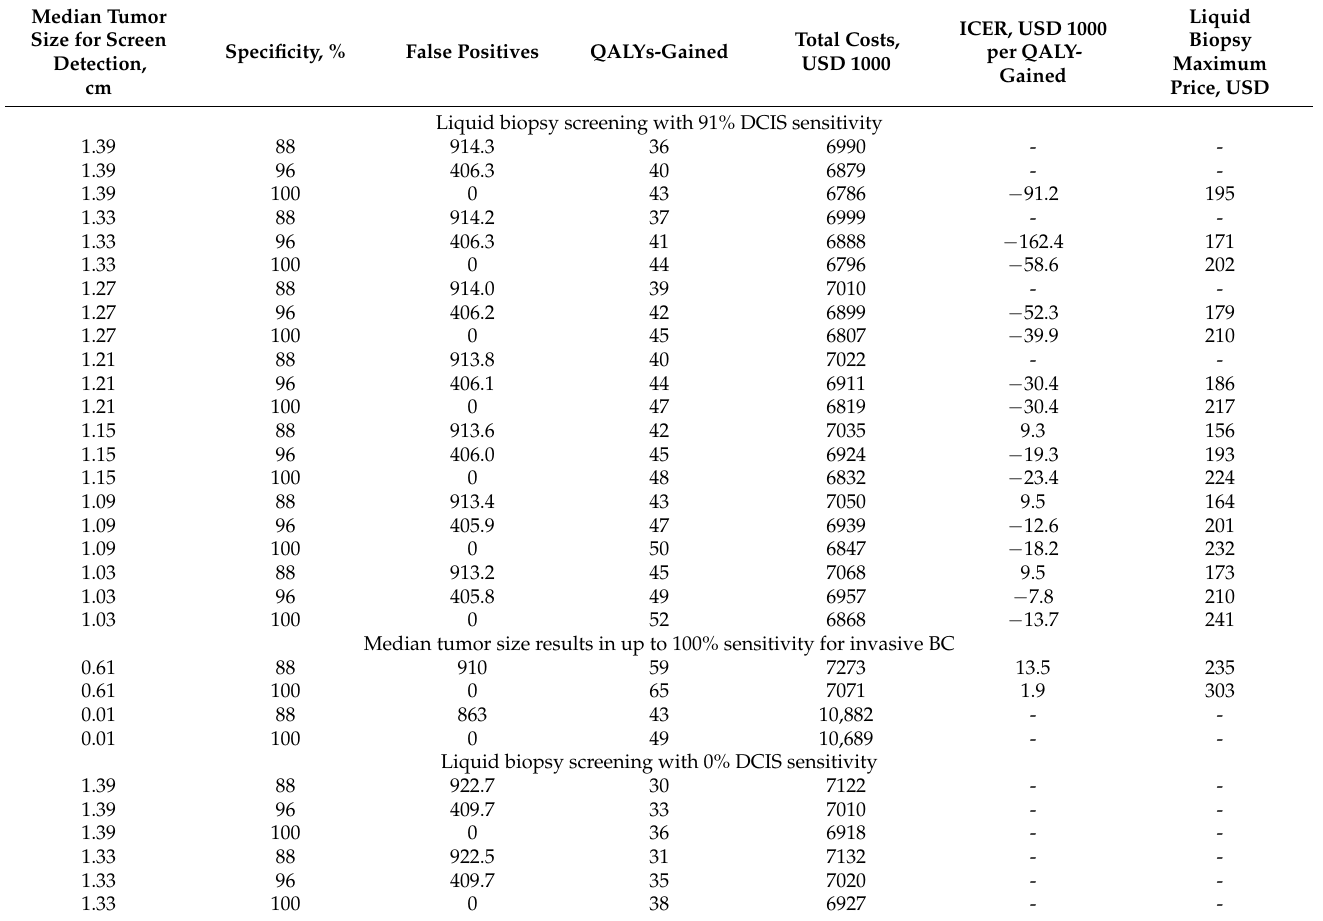
Table A1. Outcomes, cost-effectiveness, and threshold costs for routine screening with liquid biopsies per 1000 women screened over their